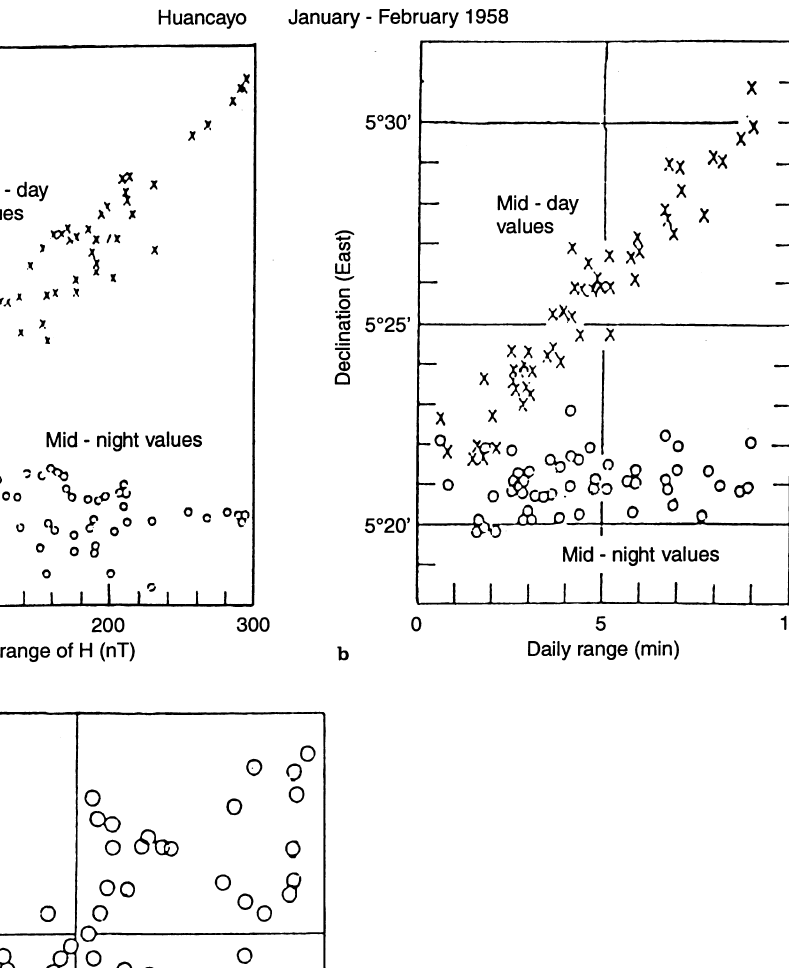
Fig. 3a Mass plots showing the relationship between the daily range of H at Huancayo with values of H at midday and midnight during January-February, 1958; b mass plot of range D in relation to midday and midnight values of D at Huancayo for January-February 1958; c mass plot of range D in relation to range H at Huancayo for January-